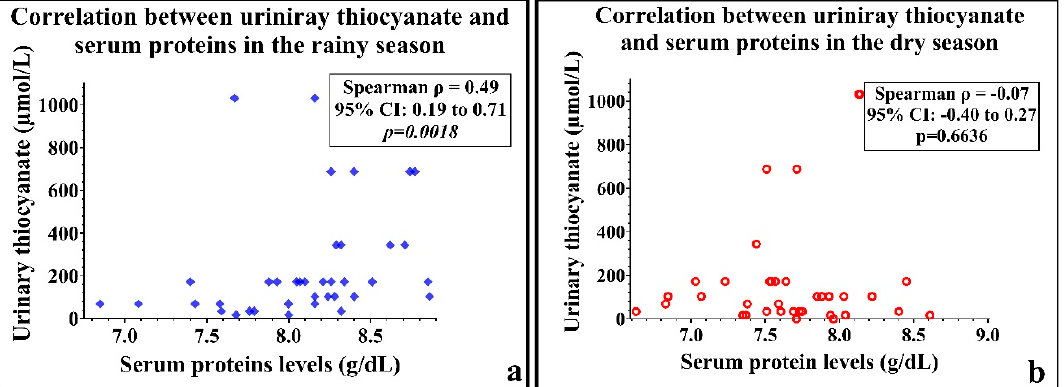
Figure 4. Correlation between urinary thiocyanate and serum protein levels during the rainy season ( a ) and the dry season ( b ) in Burhinyi, using the Spearman’s rank correlation coefficient. This figure shows a significant correlation between these two factors during the rainy season but not during the dry season.